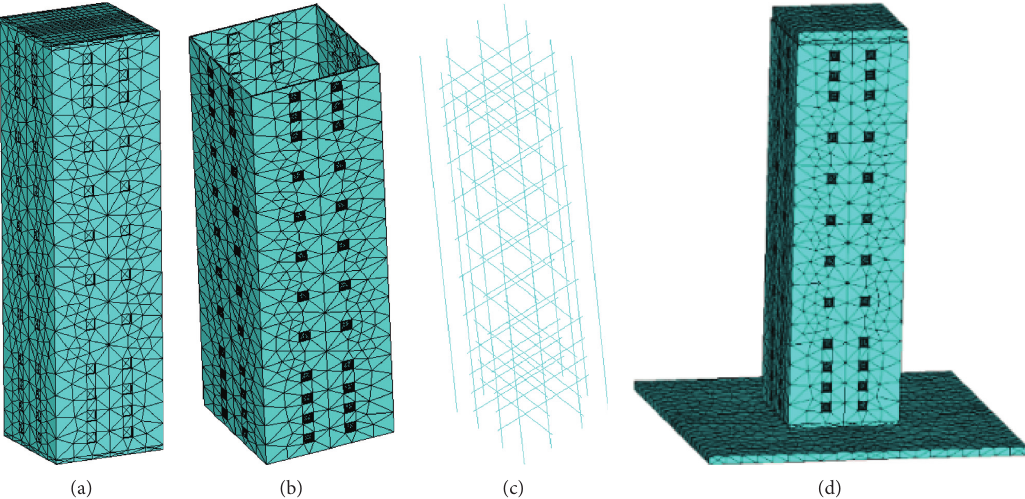
Figure 9: Models of the finite element: (a) concrete element, (b) steel tube element, (c) reinforcement element, and (d) integrated model.